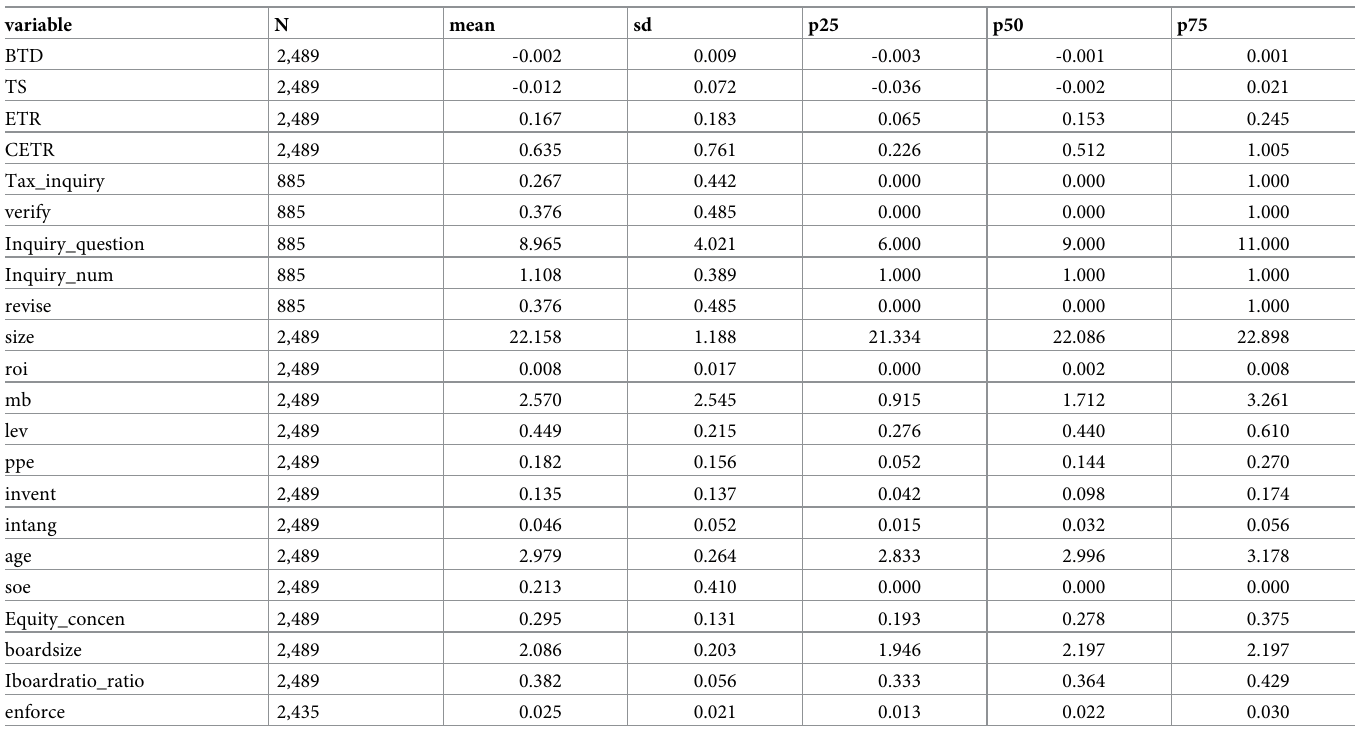
Table 3. Descriptive statistics of the main